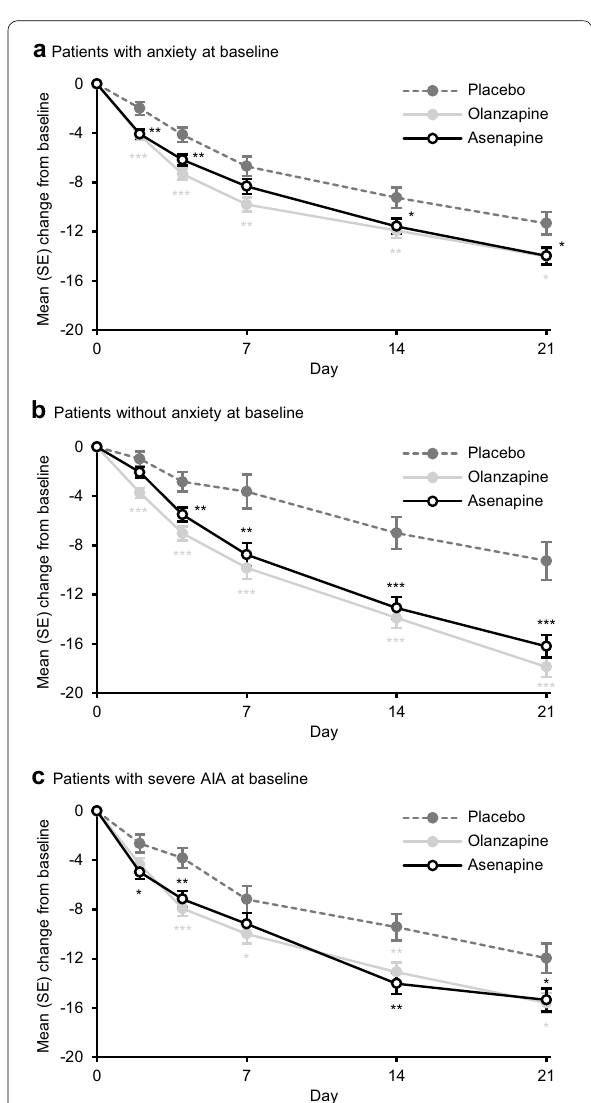
Fig. 5 Change from baseline in YMRS Total score by treatment group in BD-I mania. * p < 0.05, ** p < 0.01, *** p < 0.001 versus placebo, t test. Anxiety was defined as a PANSS anxiety item score of 3 at baseline. ≥ Irritability was defined as a YMRS irritability item score of 4 at baseline. Agitation was defined as a YMRS increased motor ≥ activity–energy item score of 3 at baseline. Severe AIA was defined ≥ as meeting the above criteria for all three AIA symptoms. Patients missing a value for the corresponding symptom at baseline were not included in the analysis. AIA, anxiety, irritability, and agitation; BD-I, bipolar I disorder; PANSS, Positive and Negative Syndrome Scale; SE, standard error; YMRS, Young Mania Rating Scale. a Patients with anxi- ety at baseline, b patients without anxiety at baseline, and c patients with severe AIA at